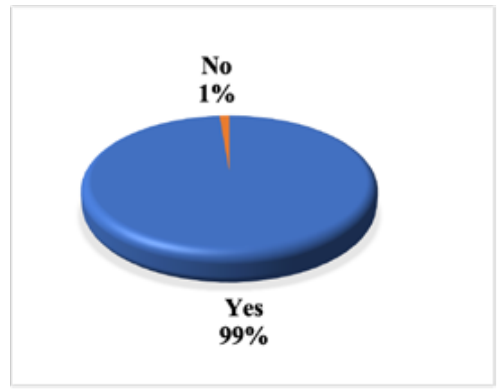
Figure 1. Knowledge of the MC